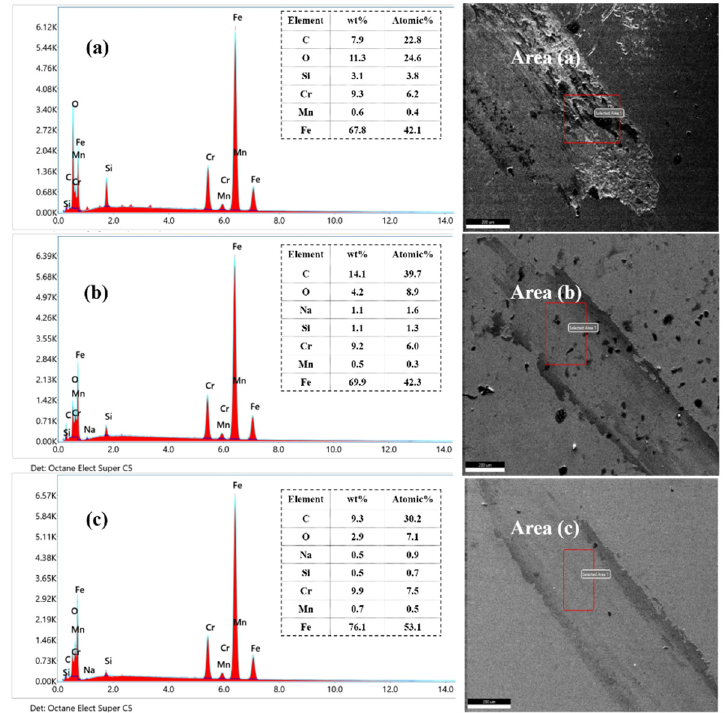
Figure 15. EDS spectra of samples treated by different processes—( a ) UT; ( b ) LQ; ( c ) LQ-LSP3.